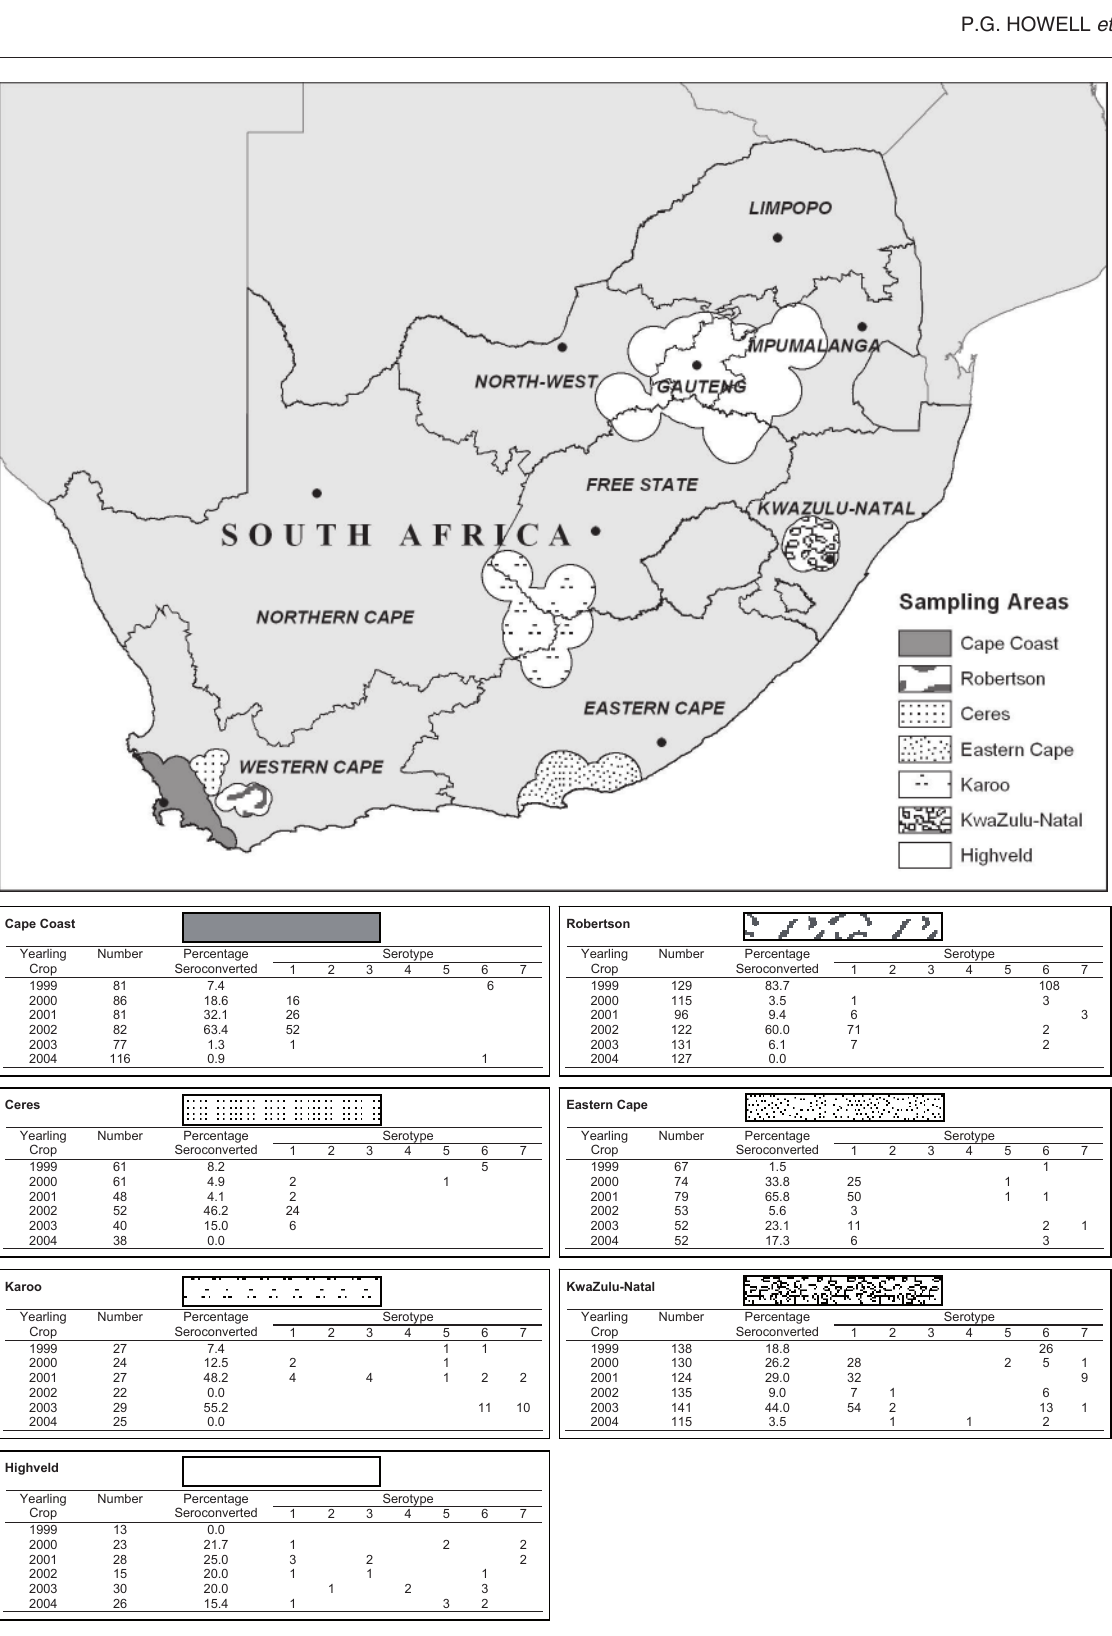
Distribution of stud farms included in the survey with numbers of yearlings sampled per year, percentage of yearlings sero- positive for equine encephalosis virus and numbers of yearlings positive for type specific antibody for each of the seven recognised serotypes of equine encephalosis virus for each of the years investigated